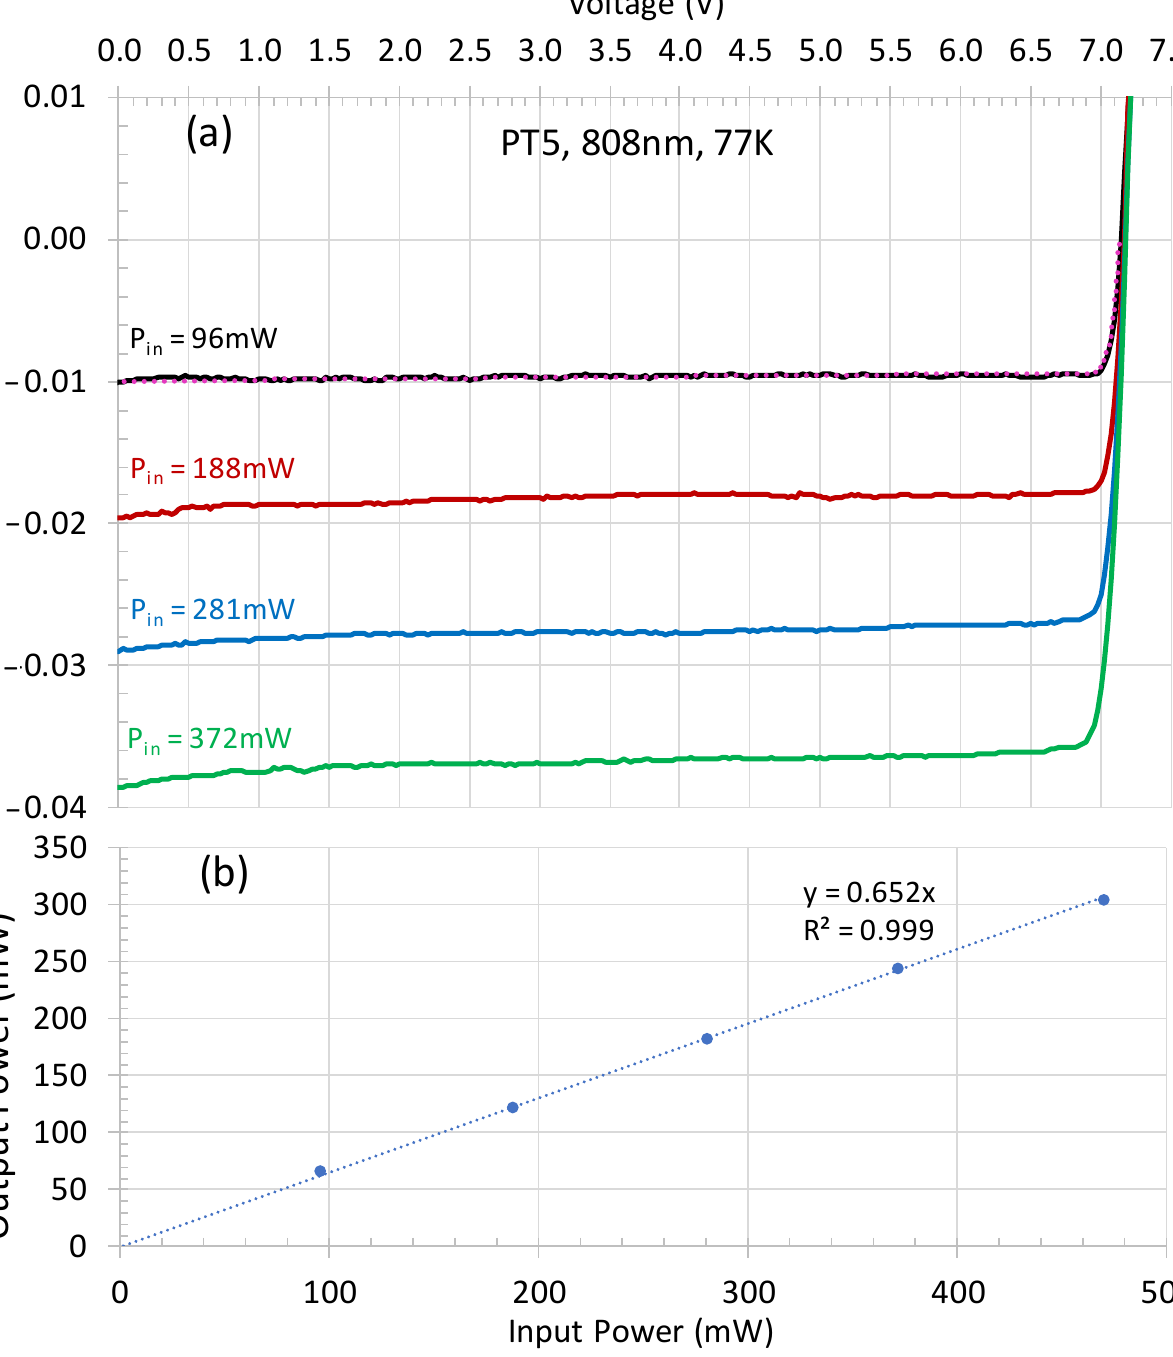
Figure 2. I-V characteristic measured at 77 K for a PT5 OPC illuminated at 808 nm with different input powers (P in ) in ( a ), and the resulting output power vs input power relationship in ( b ). The 96 mW data (black curve) in ( a ) is also fitted with a 5J ideal diode model (pink dashed line). Remarkably, for example for the 372 mW curve of Figure 2a, the open-circuit voltage (V oc ) reaches a value of V oc = 7.184 V, while the maximum power point voltage (V mpp ) is then 6.875 V. It corresponds to an average voltage of 1.437 V per subcell, yielding a bandgap voltage offset value of W oc = 0.071 V, where W oc = (Eg/q) − V oc with Eg being the bandgap energy (here, 1.508 eV for GaAs at 77 K) and q is the electronic charge. The W oc values obtained with the PT5 at low temperatures are therefore significantly better than